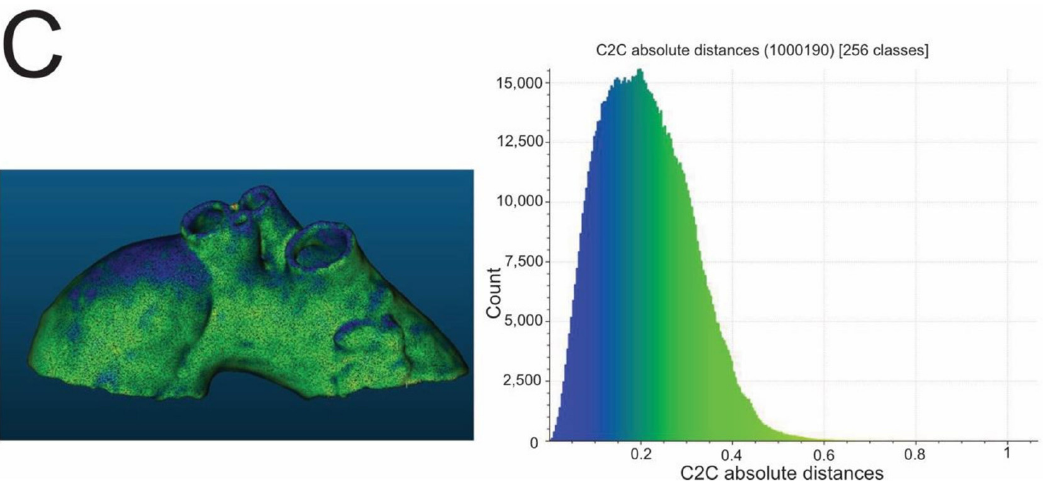
Figure 3. Exemplary color-coded differences (mm) between pre- and post-sterilization aortic tem- plates and corresponding histograms. The presented aortic templates were made of PP ( A ), flexible resin ( B ), and rigid resin ( C ). All were sterilized in a 105 ◦ C autoclave.